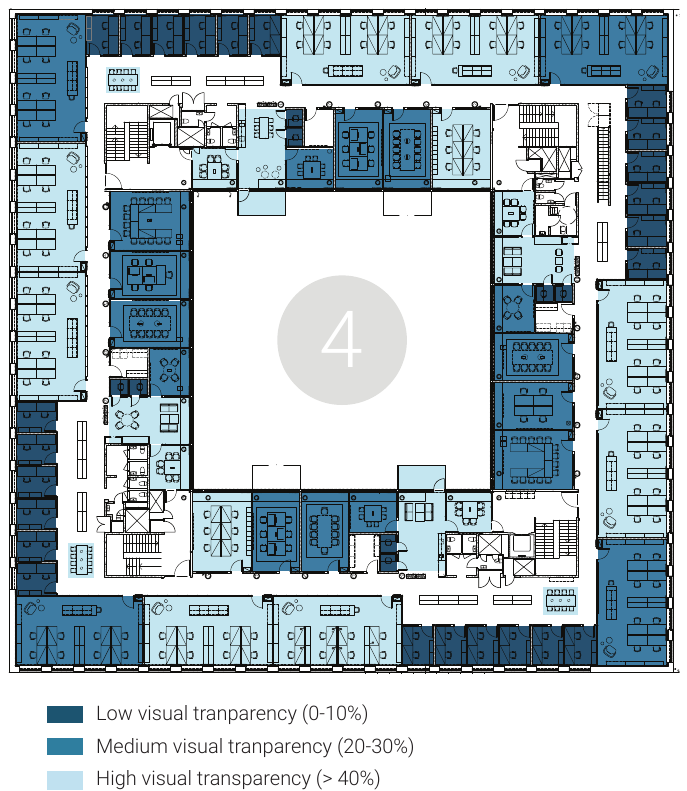
Figure 8. Example of visual transparency on floor 4, calculated as the ratio of the glass/open area to solid wall